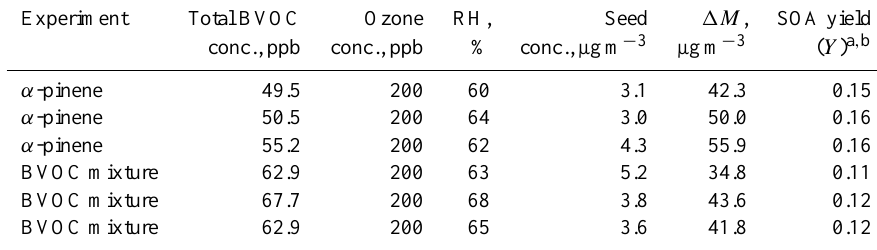
Table 1. Summary of α -pinene and BVOC mixture ozonolysis